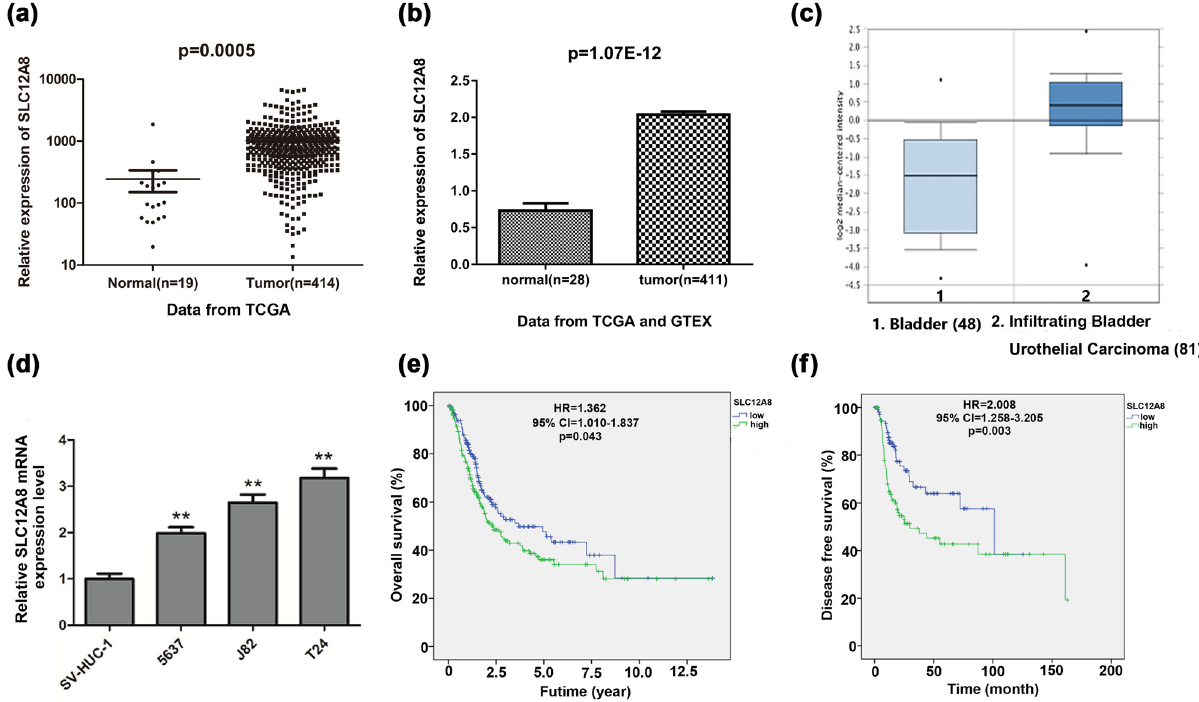
Figure 1: Expression of SLC12A8 in bladder cancer and its prognostic value. ( a ) SLC12A8 expression level was remarkably higher in bladder cancer tissues ( n = 414 ) than that in normal tissues ( n = 19 ) based on data from the TCGA database, p = 0.0005. ( b ) Data from TCGA and GTE X showed that SLC12A8 was signi fi cantly upregulated in bladder cancer samples ( n = 411 ) than that in normal samples ( n = 28 ) , p = 1.07 × 10 − 12 . ( c ) SLC12A8 expression was meaningfully higher in in fi ltrating bladder urothelial carcinoma ( n = 81 ) compared with normal bladder ( n = 48 ) in the Oncomine dataset, p < 0.0001. ( d ) SLC12A8 expression in ( 5637, J82, and T24 ) cell lines was higher than normal control cells ( SV - HUC - 1 ) , ** p < 0.01. ( e ) Kaplan – Meier analysis showed the bladder cancer patients ’ survival with unequal SLC12A8 expression level, p = 0.043. ( f ) Kaplan – Meier analysis showed that high expression of SLC12A8 led to the worse disease - free survival in patients with bladder cancer, p =